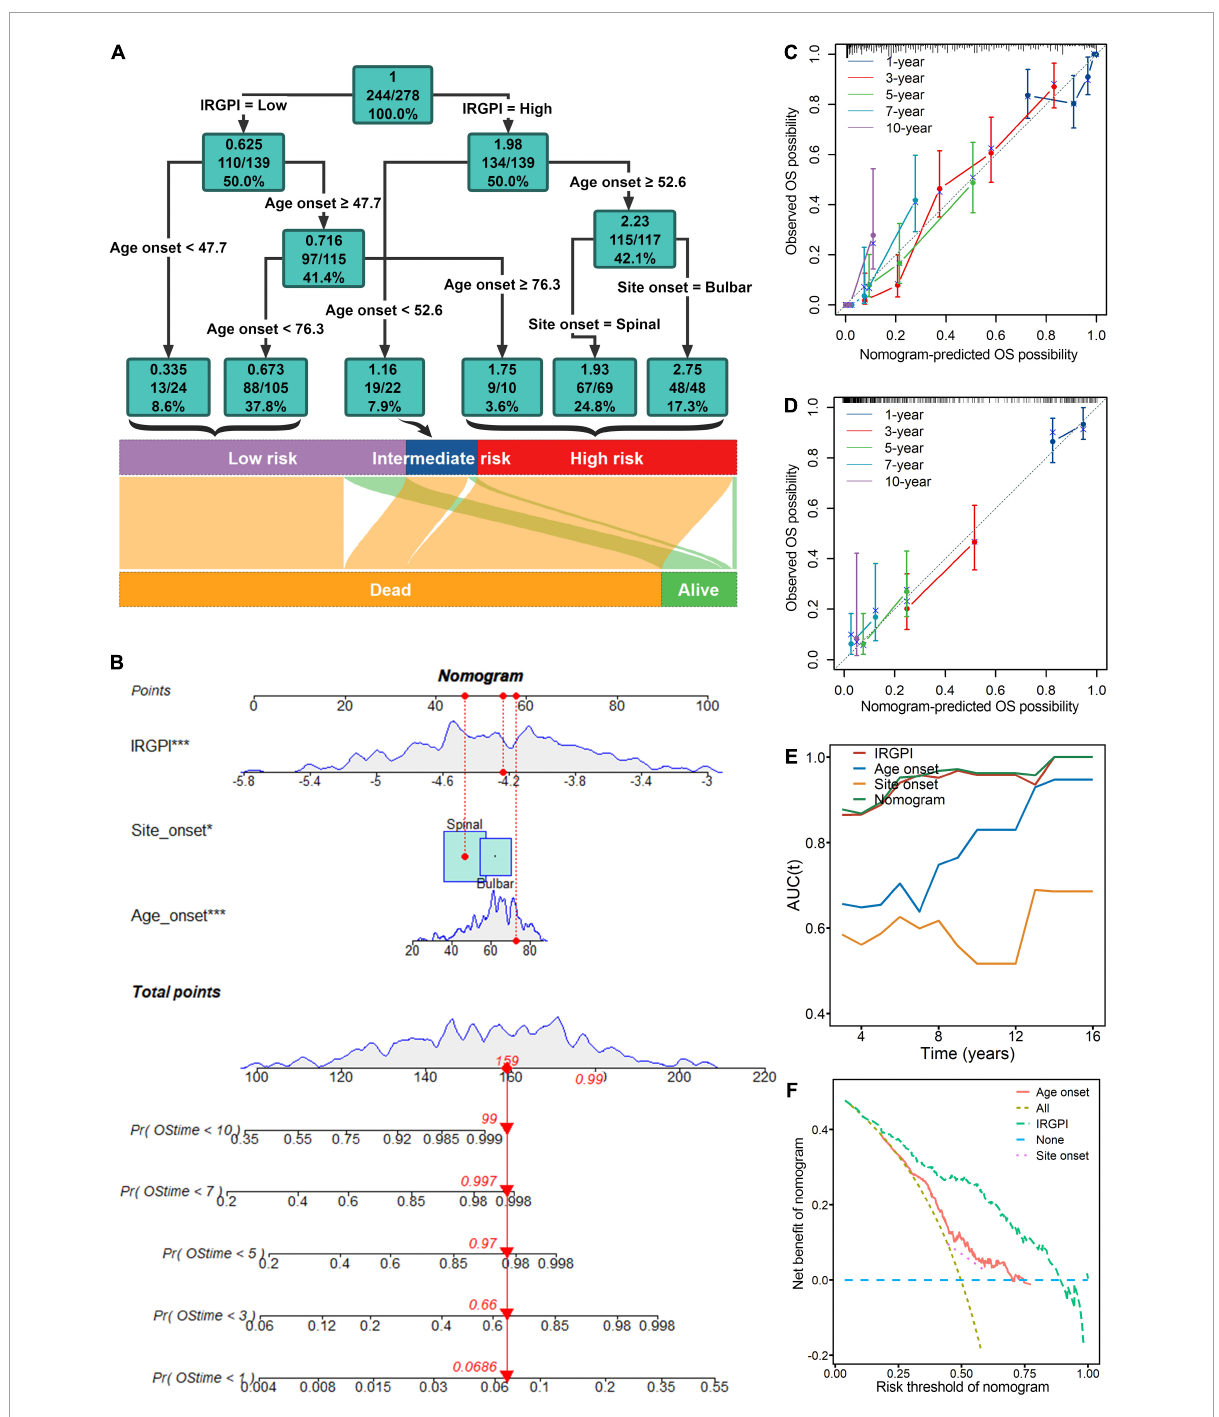
FIGURE4 Risk stratification and survival prediction are improved by combining immune signatures of the immune-related gene prognostic index (IRGPI) with clinical features. (A) The decision tree was developed to enhance risk stratification. (B) The nomogram was created for the quantitative risk evaluation of individual patients. Calibration curves for 1-, 3-, 5-, 7-, and 10-years showed effective consistency between the prediction and observation in the survival probability in the training (C) and testing cohort (D) . (E) Both the nomogram and the IRGPI in time-dependent area under the curve (tAUC) plot were higher than the clinical features of age onset and site onset, which suggested that the nomogram and the IRGPI led a greater prediction performance. (F) Decision curve analysis (DCA) demonstrated that the nomogram had improved net benefits at a range of clinically reasonable risk thresholds, which had effective clinical application prospects for making valuable and informed judgments of the prognosis. * P < 0.05; *** P <